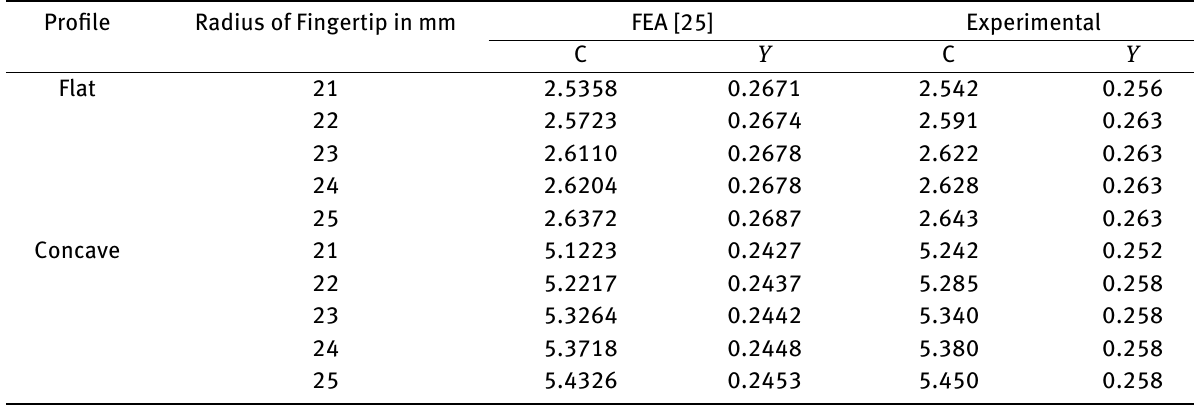
Figure 4: Sample imprints of fingertips on various profile. Table 1: Comparison and Validation of Experimental Results